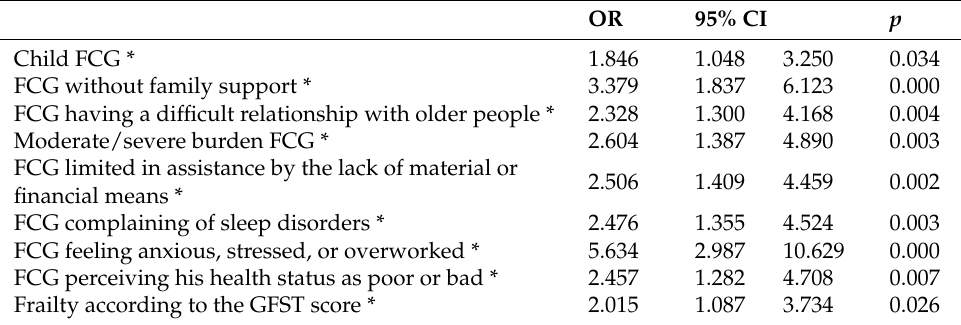
Table 3. The factors associated with FCG